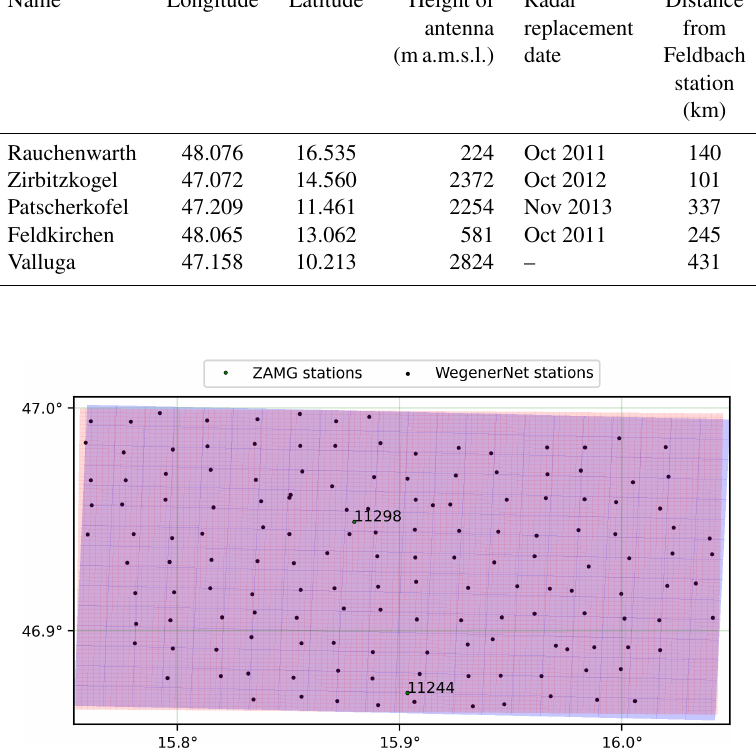
Figure B1. Locations of WegenerNet stations (black circles) and ZAMG stations (green circles), WegenerNet original (red cells), and after the transforming–regridding process (blue cells).